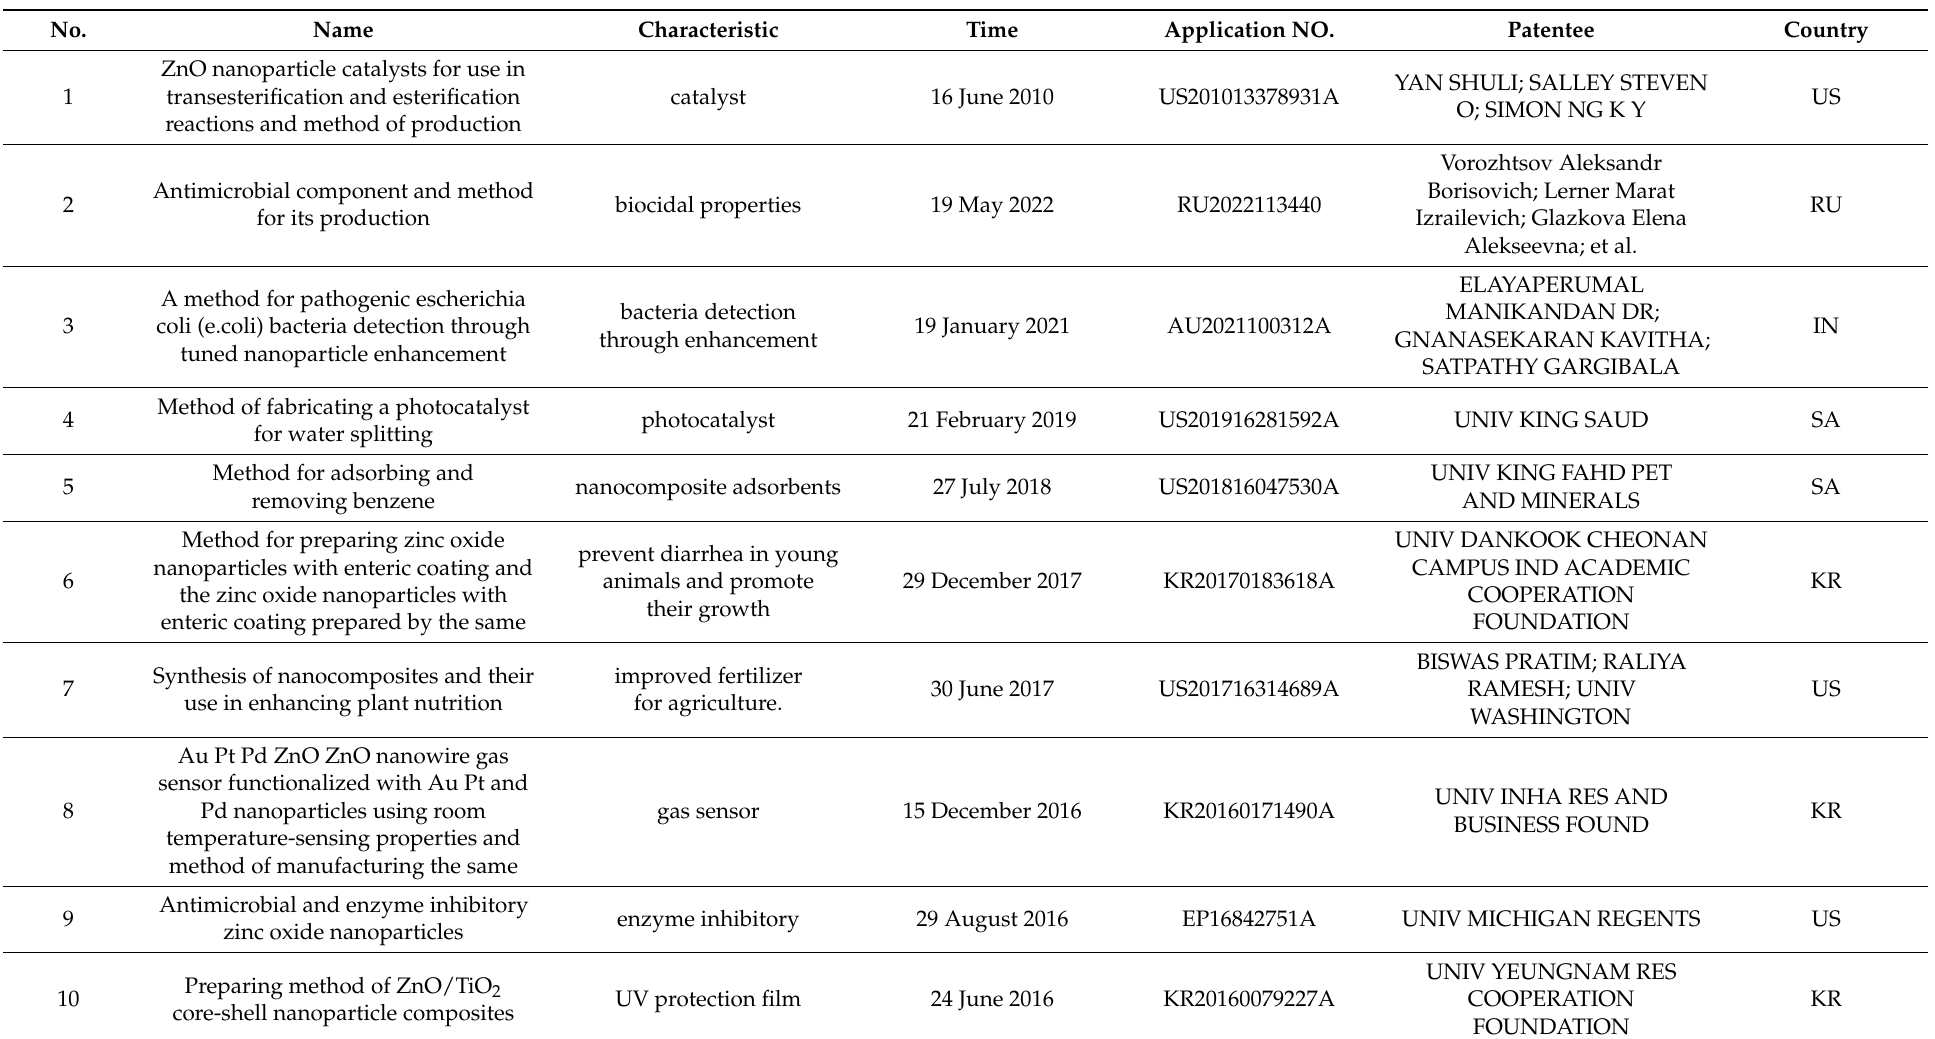
Table 2. The patents on the application of ZnO nanoparticles in food and agriculture.